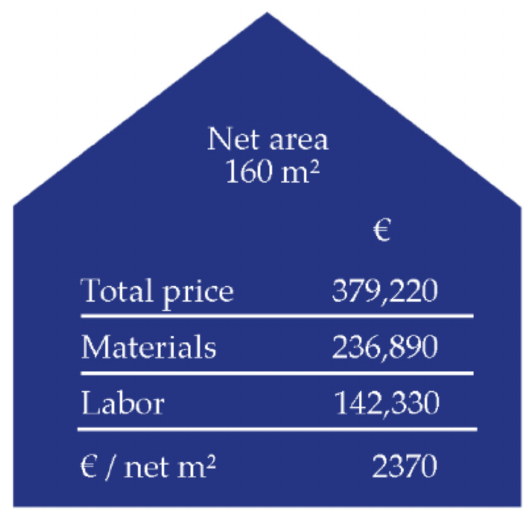
Figure 8. The average small house project costs in